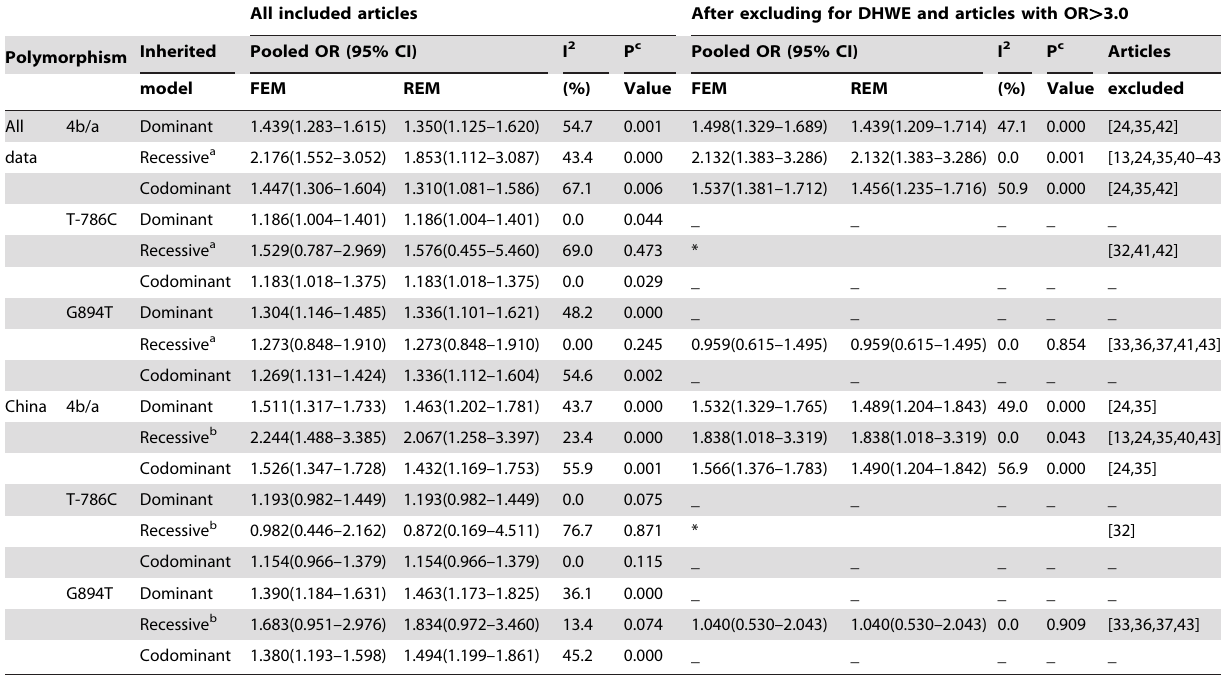
All included articles After excluding for DHWE and articles with OR .